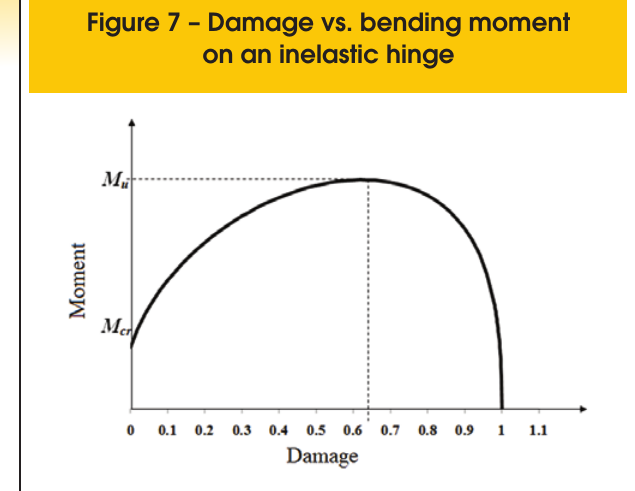
Figure 6 – Lumped damage variables on a straight element [4]